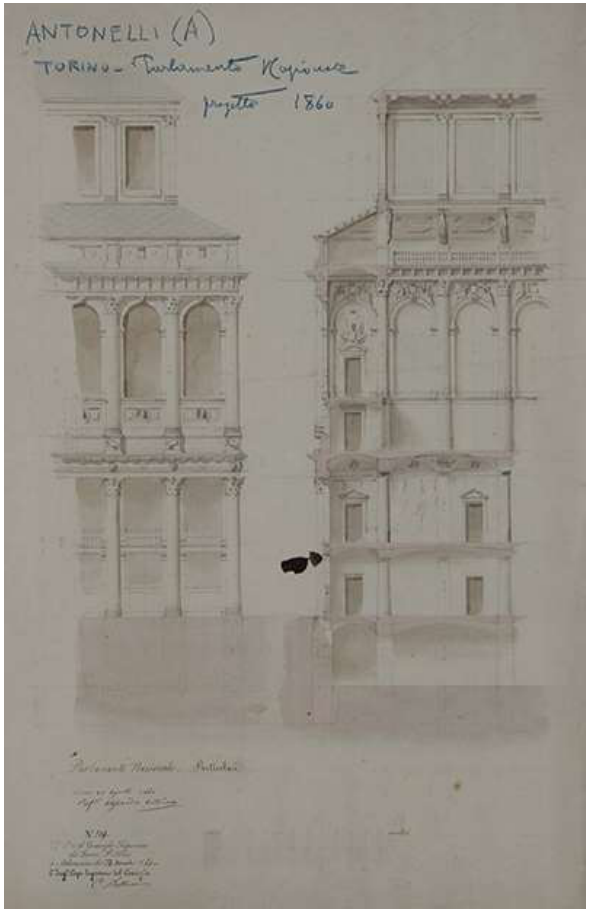
Figure 3. Alessandro Antonelli, National Parliament, elevation,